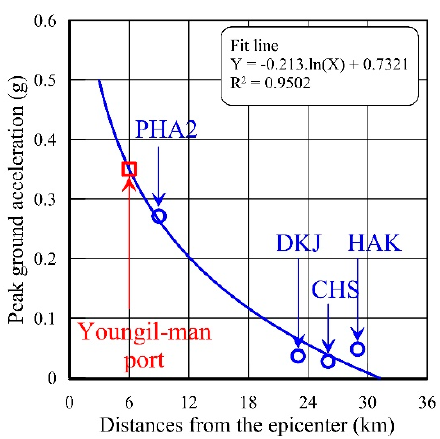
Figure 11. Estimated peak ground acceleration (PGA) at Youngil-man port from the relationship between recorded PGAs and distances from the epicenter of different recording stations.